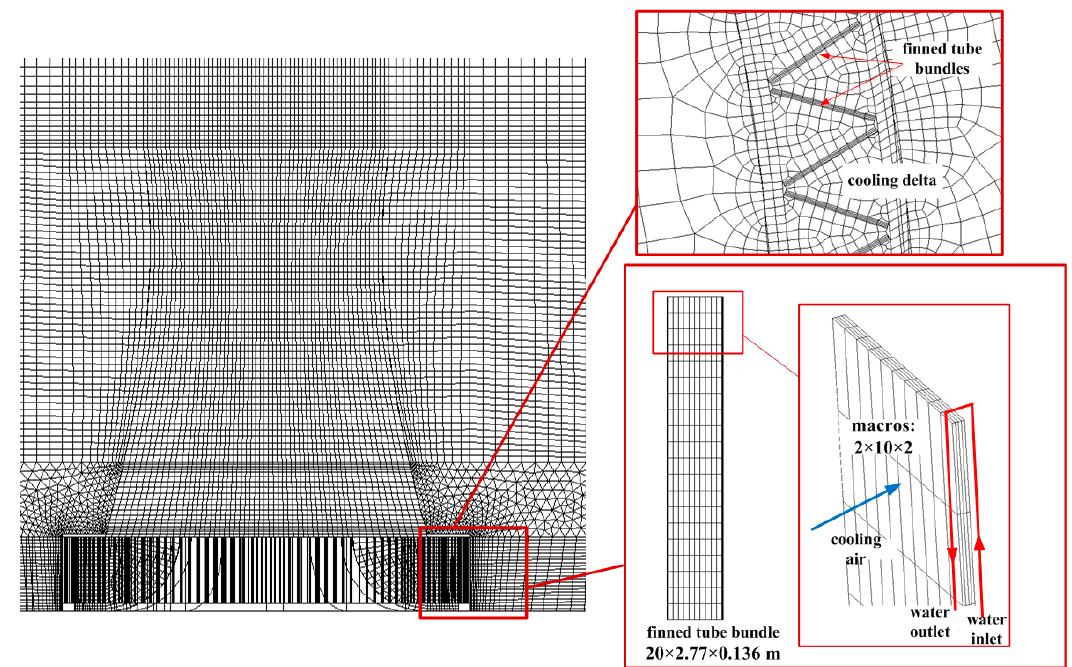
Figure 5. Local grids for dry-cooling tower and finned tube bundles.